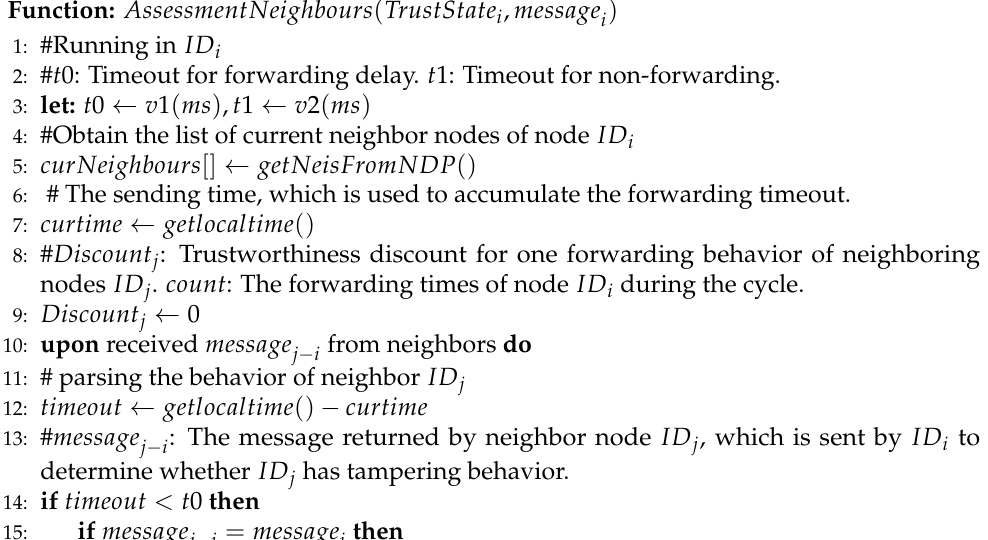
Algorithm 1 Function: AssessmentNeighbours with TrustState i and message